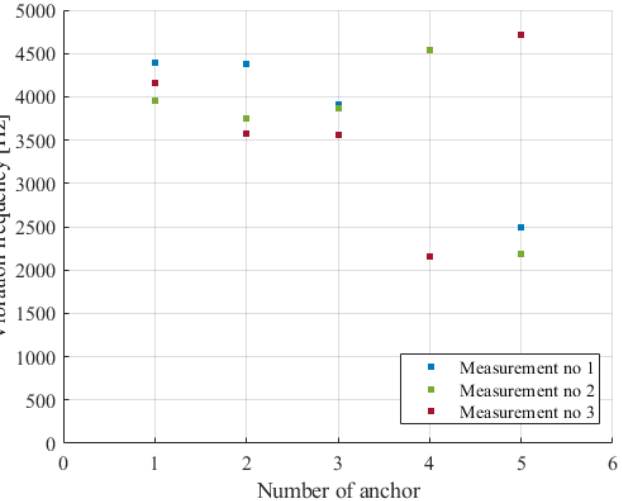
Figure 12. Measurement of anchor vibration frequency in a Vernier longitudinal without filtration.